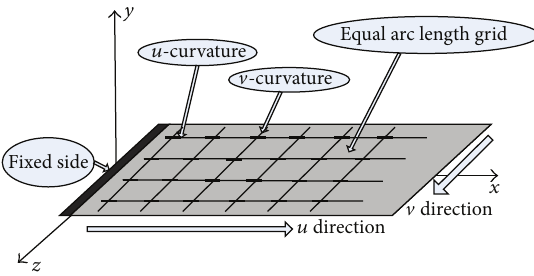
Figure 1: Schematic diagram of partial equal arc length grid.